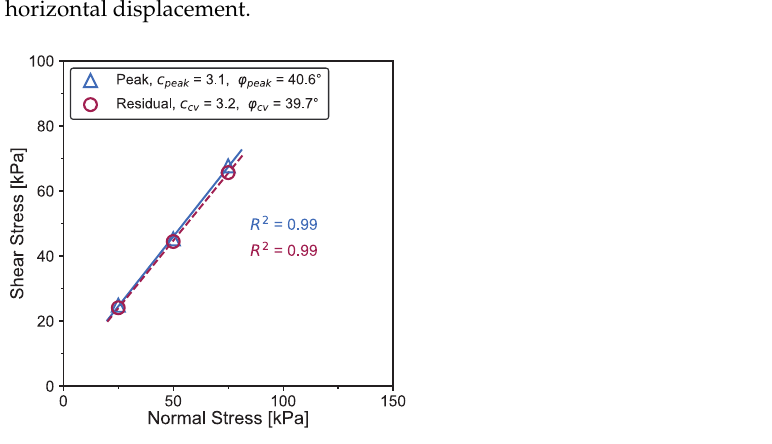
Figure 7. Peak and residual failure envelopes from direct shear tests of JEZ-1.